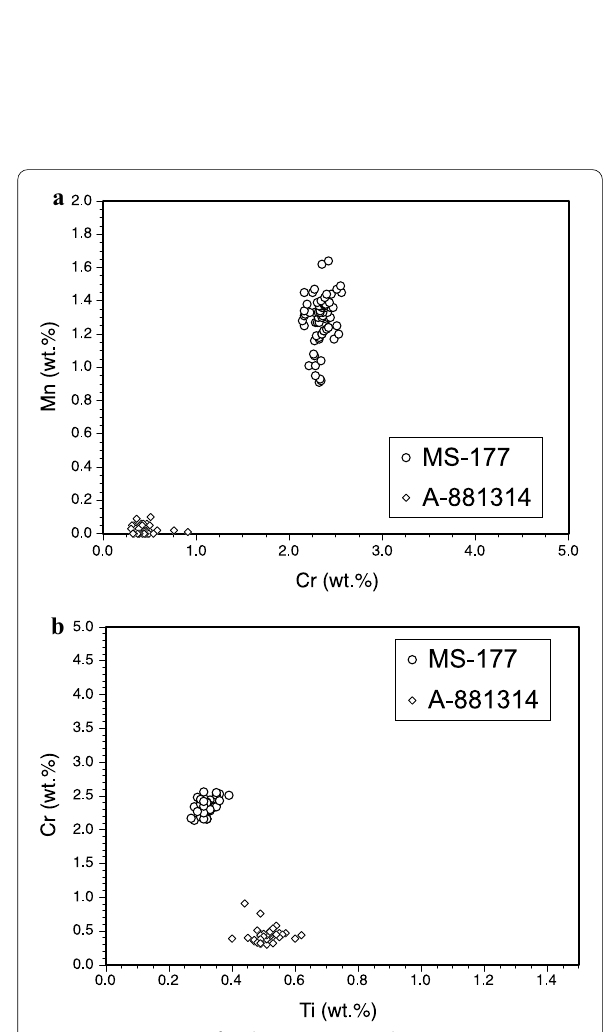
Fig. 5 Compositions of troilite in MS-177 and A-881314 on a Cr versus Mn plot, and b Ti versus Cr